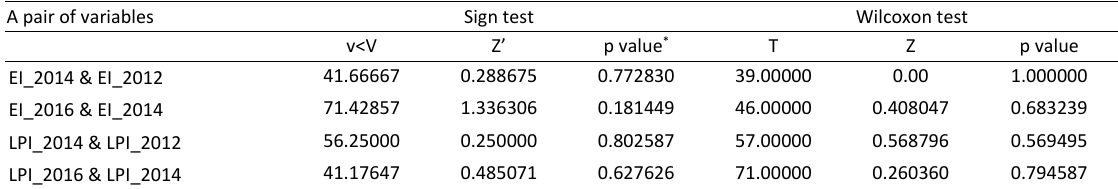
Table 5: Sign test and Wilcoxon test for ranking of entrepreneurship rate and logistics performance A pair of variables